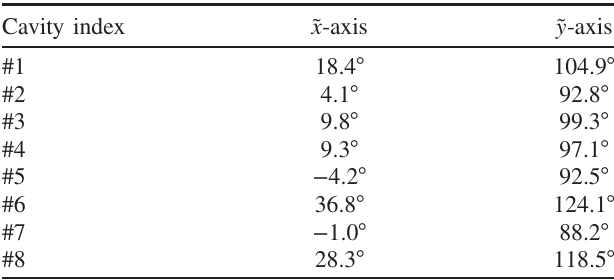
TABLE I. Rotation angles of the two polarization axes with respect to the horizontal plane.